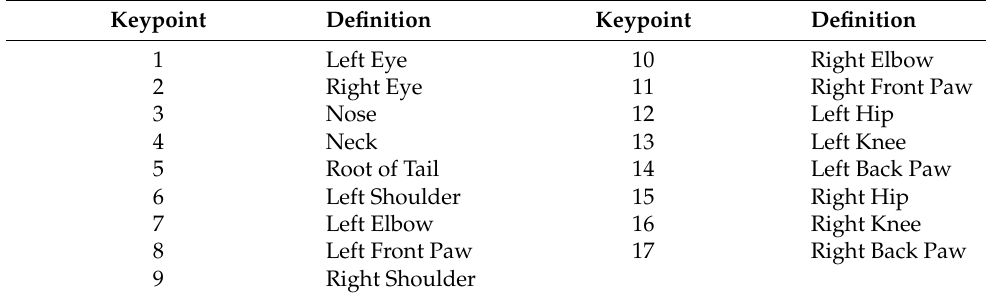
Table 1. Illustrating the definition of animal